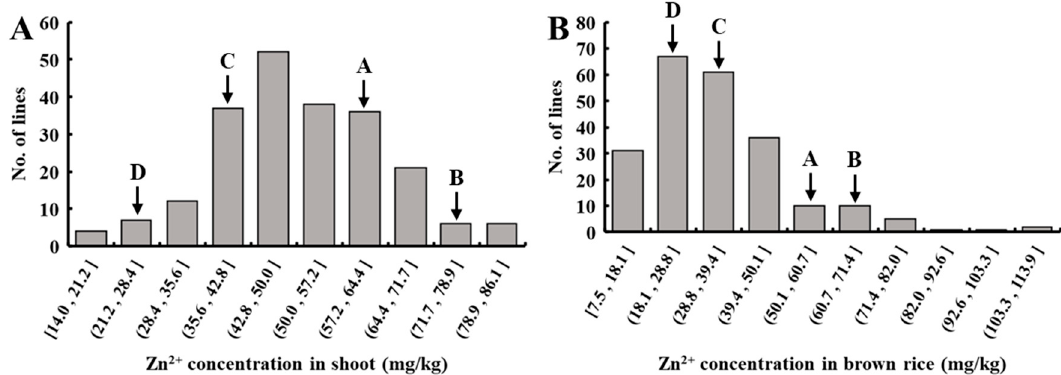
Figure 1. Distribution of Zn 2+ concentration in shoots at the seedling stage and in grains at the mature stage in the DC1 population. A pot experiment was carried out in the greenhouse of the Agricultural Genomics Institute in Shenzhen, Chinese Academy of Agricultural Sciences. The shoot and grain samples were collected at the seedling stage (3 weeks after transplanting) and the mature stage, respectively. Frequency distribution of ( A ) Zn 2+ concentration in shoots at the seedling stage, and ( B ) Zn 2+ concentration in brown rice at the mature stage.